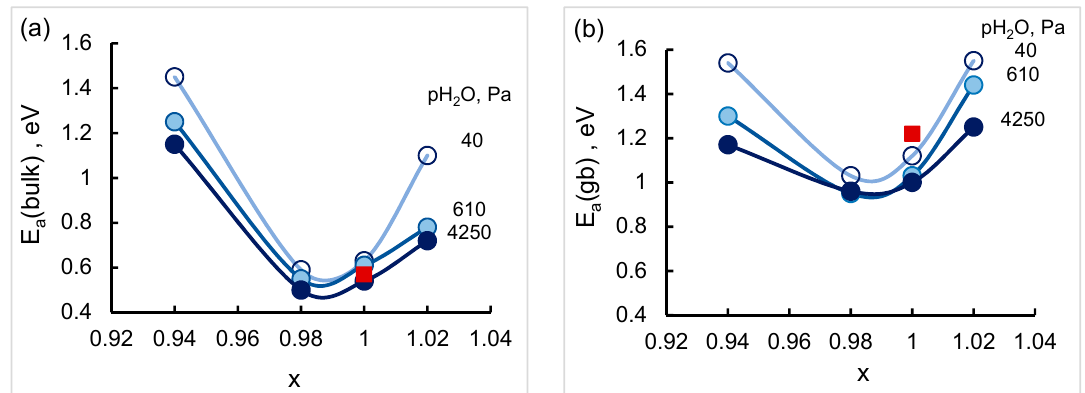
Figure 11. Activation energies of the bulk ( a ) and grain boundary ( b ) conductivity of SZYx. The lines between points are only a guide to the eye. Activation energies for SrZr 0.95 Y 0.05 O 3 − δ measured in wet nitrogen [25] are given for comparison (red squares).